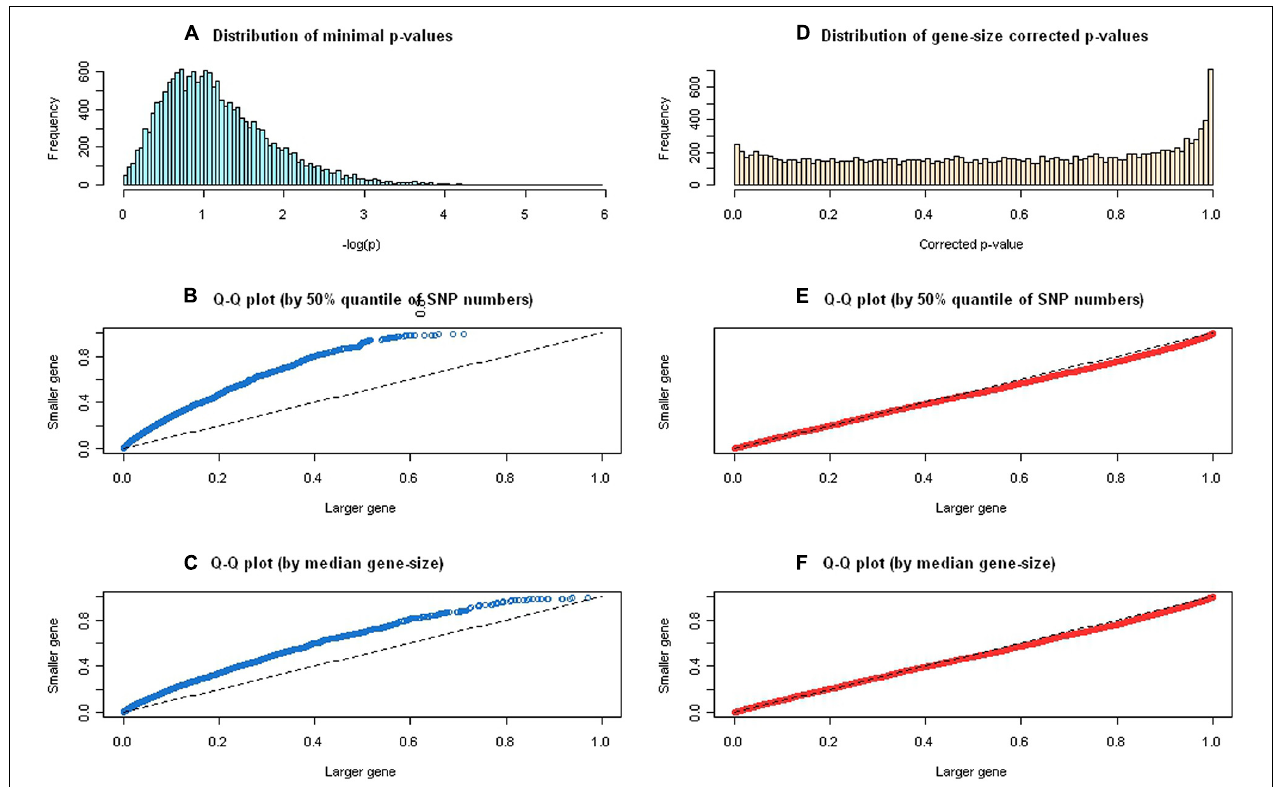
FIGURE 2 | The distribution of minimal p -values and quantile-quantile plots before and after gene-size correction. (A) Distribution of logarithm of minimal p -values was skewed to the right. (B) The quantile-quantile plot, using 50% quantile of single-nucleotide polymorphism (SNP) numbers, showed a significant correlation between minimal p -values and the gene-size. (C) The quantile-quantile plot, using median gene size, showed a significant correlation between minimal p -values and the gene size. (D) Distribution of logarithm of gene-size corrected p -values demonstrated uniformly distributed from [0,1]. (E) The quantile-quantile plot, using 50% quantile of SNP numbers, showed no significant correlation between gene-size corrected p -values and the gene-size. (F) The quantile-quantile plot, using median gene size, showed no significant correlation between gene-size corrected p -values and the gene